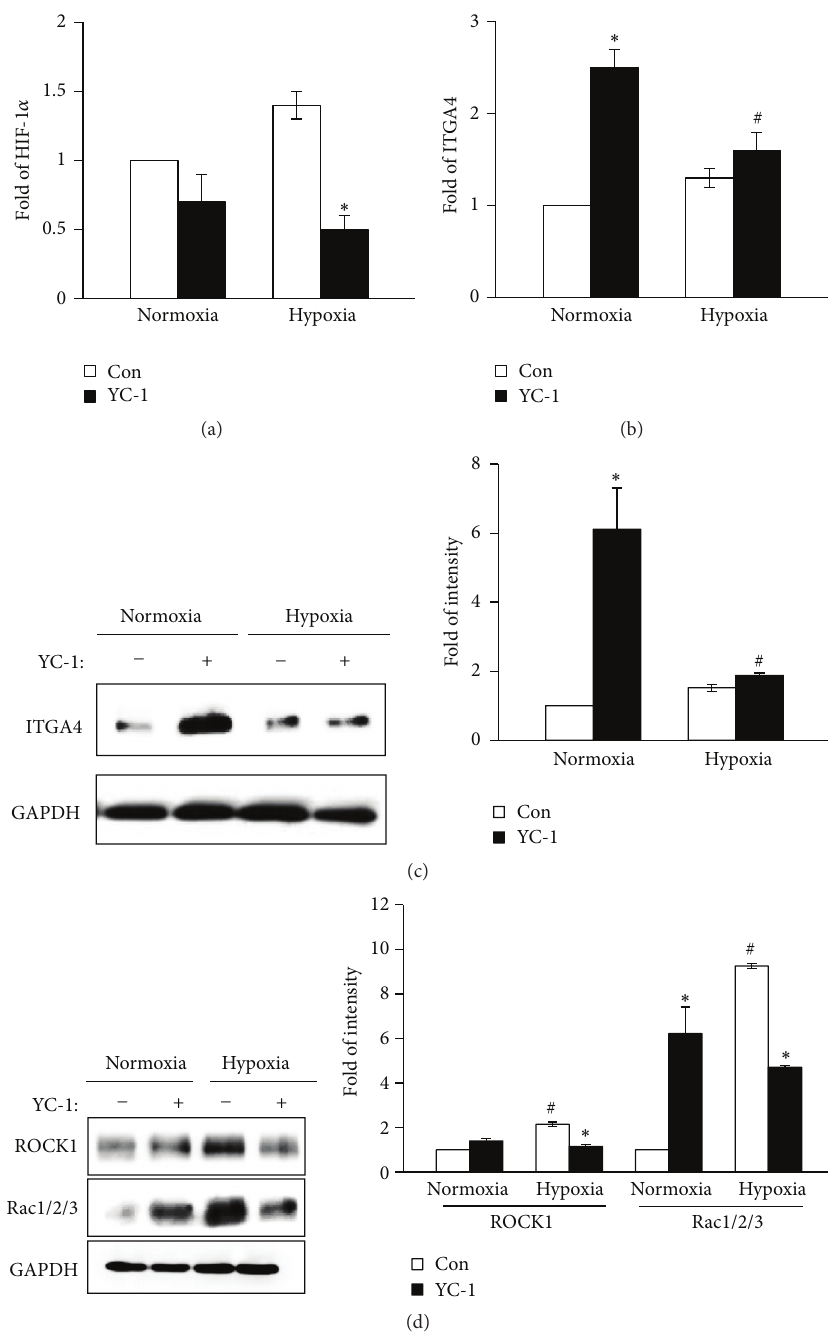
Figure 3: Alteration of integrin 𝛼 4 -mediated signaling pathway in BM-MSCs under hypoxia. The mRNA expression levels of HIF-1 𝛼 (a) and integrin 𝛼 4 (b) in BM-MSCs were determined by real-time PCR. 18S rRNA was used as the loading control. Protein expression levels of integrin 𝛼 4 (c) and ROCK1 and Rac1/2/3 (d) in BM-MSCs were assessed by Western blotting. GAPDH was used as the loading control. ∗ 𝑃 < 0.05 (compared with YC-1 nontreated group) and # 𝑃 < 0.05 (compared with normoxic group). HIF-1 𝛼 : hypoxia-inducible factor-1 𝛼 ; ITGA4: integrin 𝛼 4 ; ROCK1: Rho-associated kinase